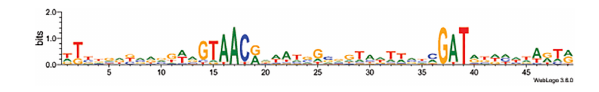
FIGURE 1 | Sequence logo of the 11 studied σ D -dependent promoters. The logo was made using Weblogo3 (Crooks et al., 2004).